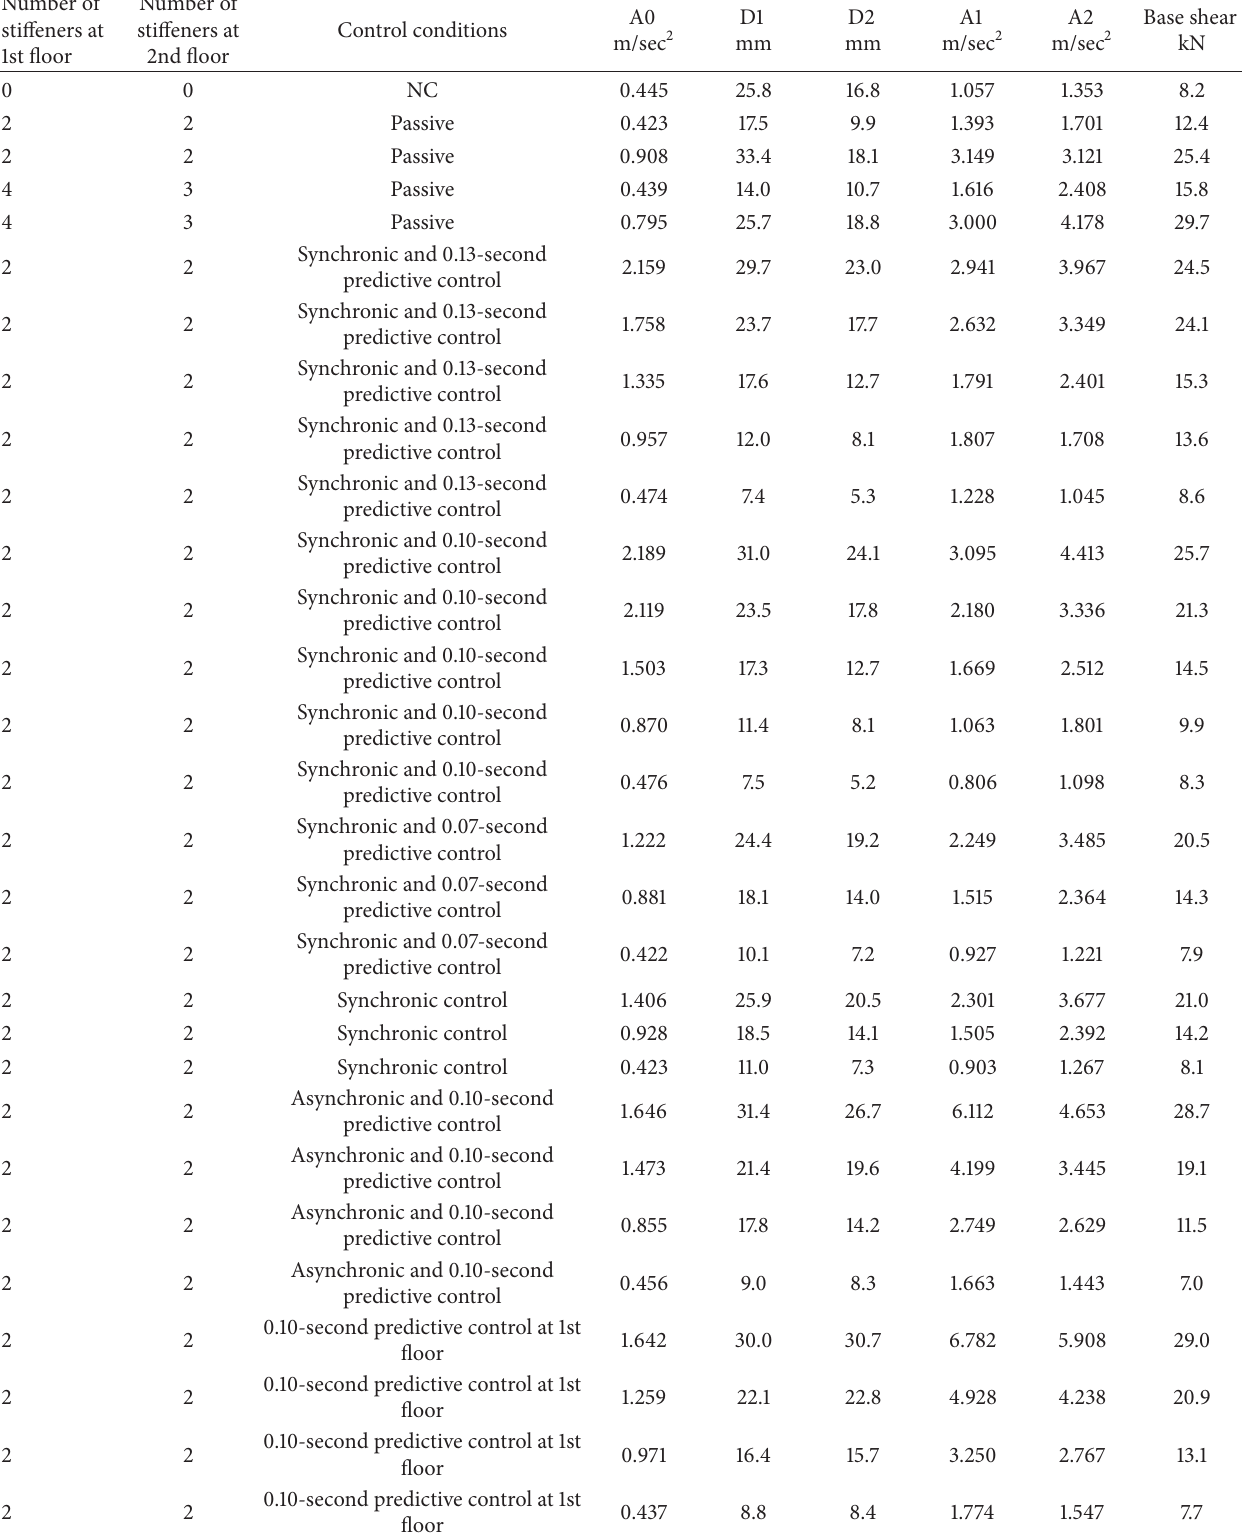
Table 2: The maximum structural response of test structure under excitation of El Centro earthquake record with various control conditions and different peak ground